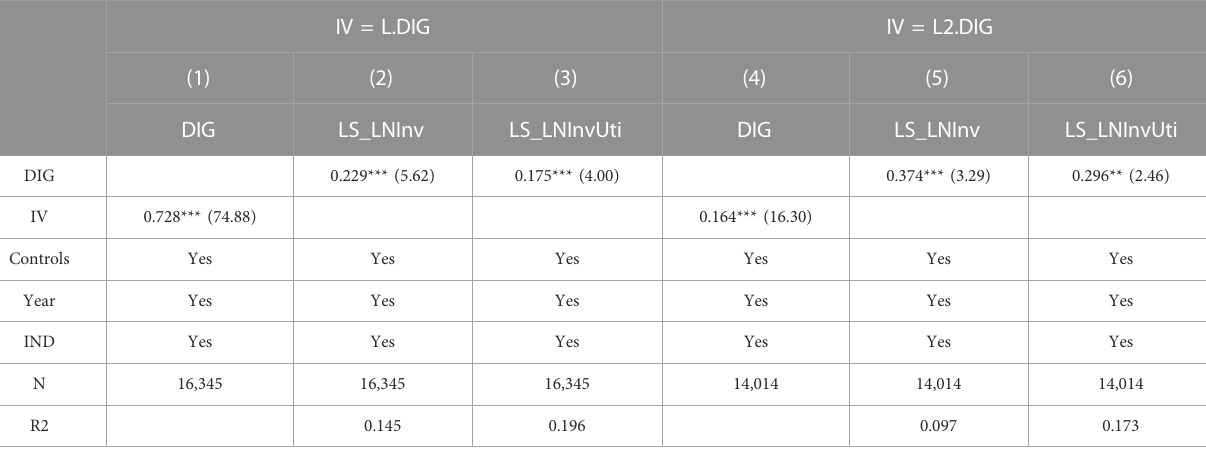
TABLE 9 Test results of two-stage least squares.